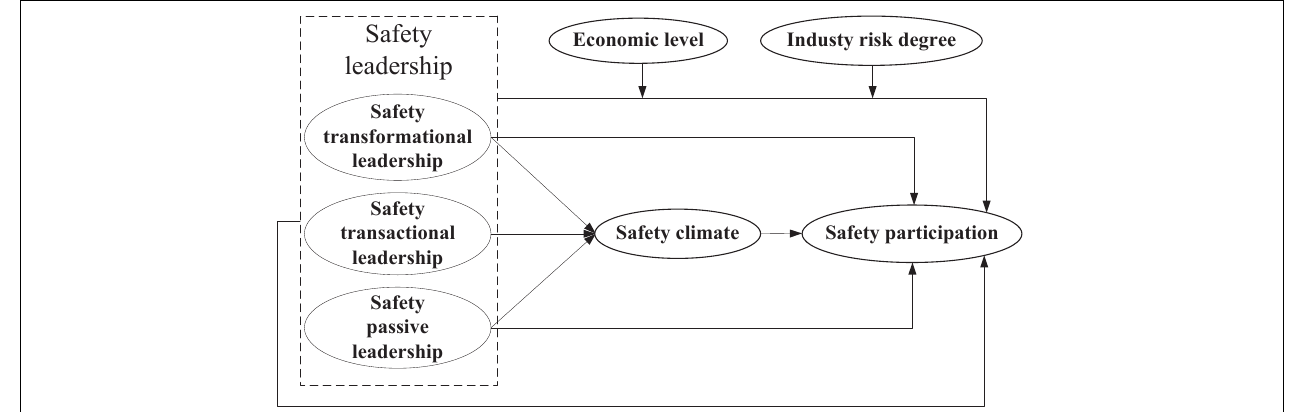
FIGURE 1 | Conceptual model.